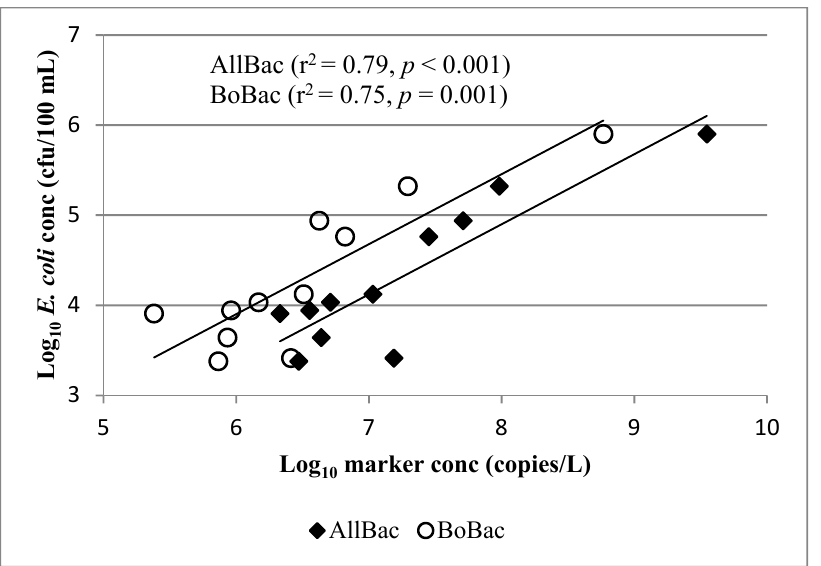
Figure 4. Linear regression analysis showing correlation of AllBac and BoBac concentrations to E. coli concentrations in runoff from BCSC sites when stocked.